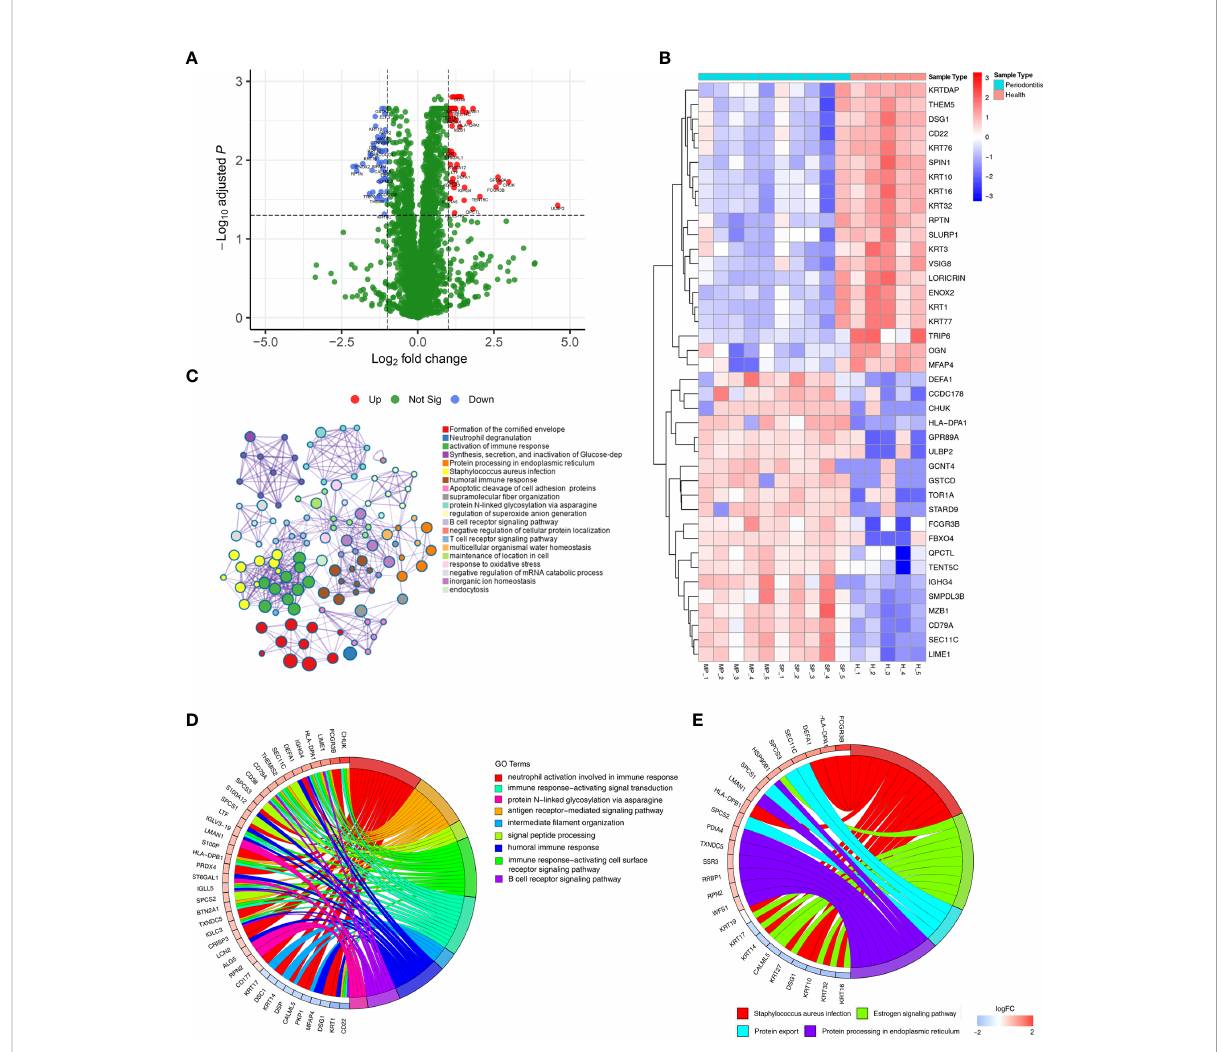
FIGURE 2 DEPs were identi fi ed in gingival tissues from periodontitis versus healthy tissues. (A) Volcano plot displaying DEPs in gingival tissues. Green dots indicate down-regulated DEPs, and red dots indicate up-regulated DEPs. (B) Heatmap of the top 30 DEPs. Red cells represent up-regulated DEPs, and blue cells represent down-regulated DEPs. (C) Metascape enrichment network visualization shows the intra-cluster and inter-cluster similarities of enriched terms for the 115. Nodes of the same color belong to the same cluster. Terms with similarity scores > 0.3 are linked by edges, and nodes in the same condensed network are colored with p values. (D, E) Circos plots represent signi fi cantly enriched GO terms (D) and pathways (E) associated with